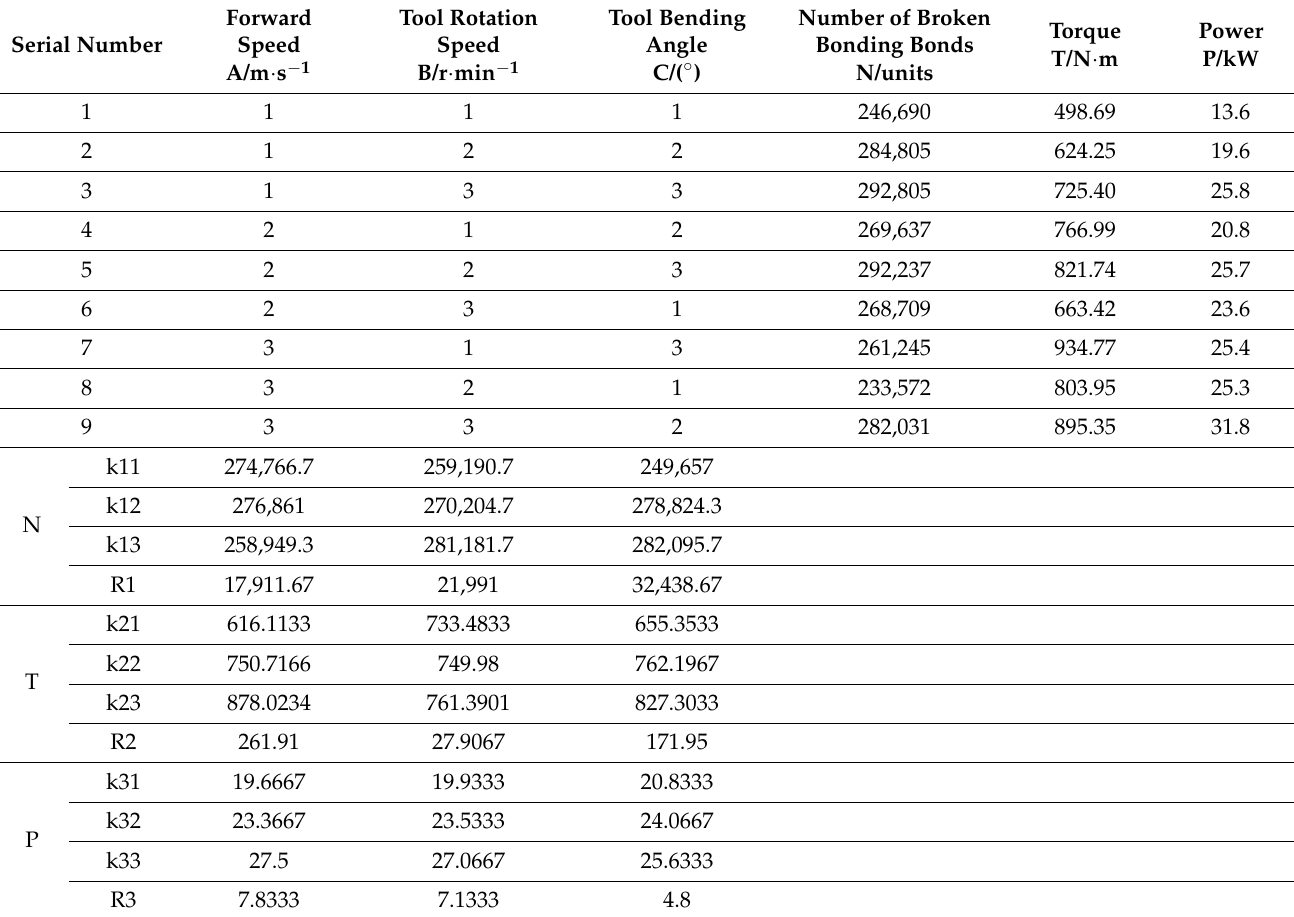
Table 5. Analysis of extreme differences in orthogonal test